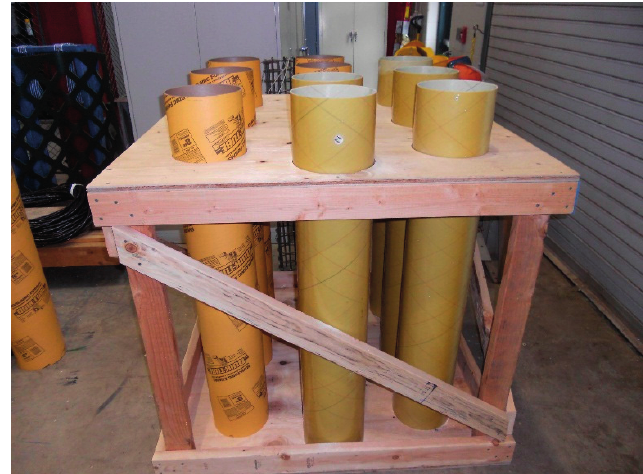
Figure 6. Wooden framework for column construction.